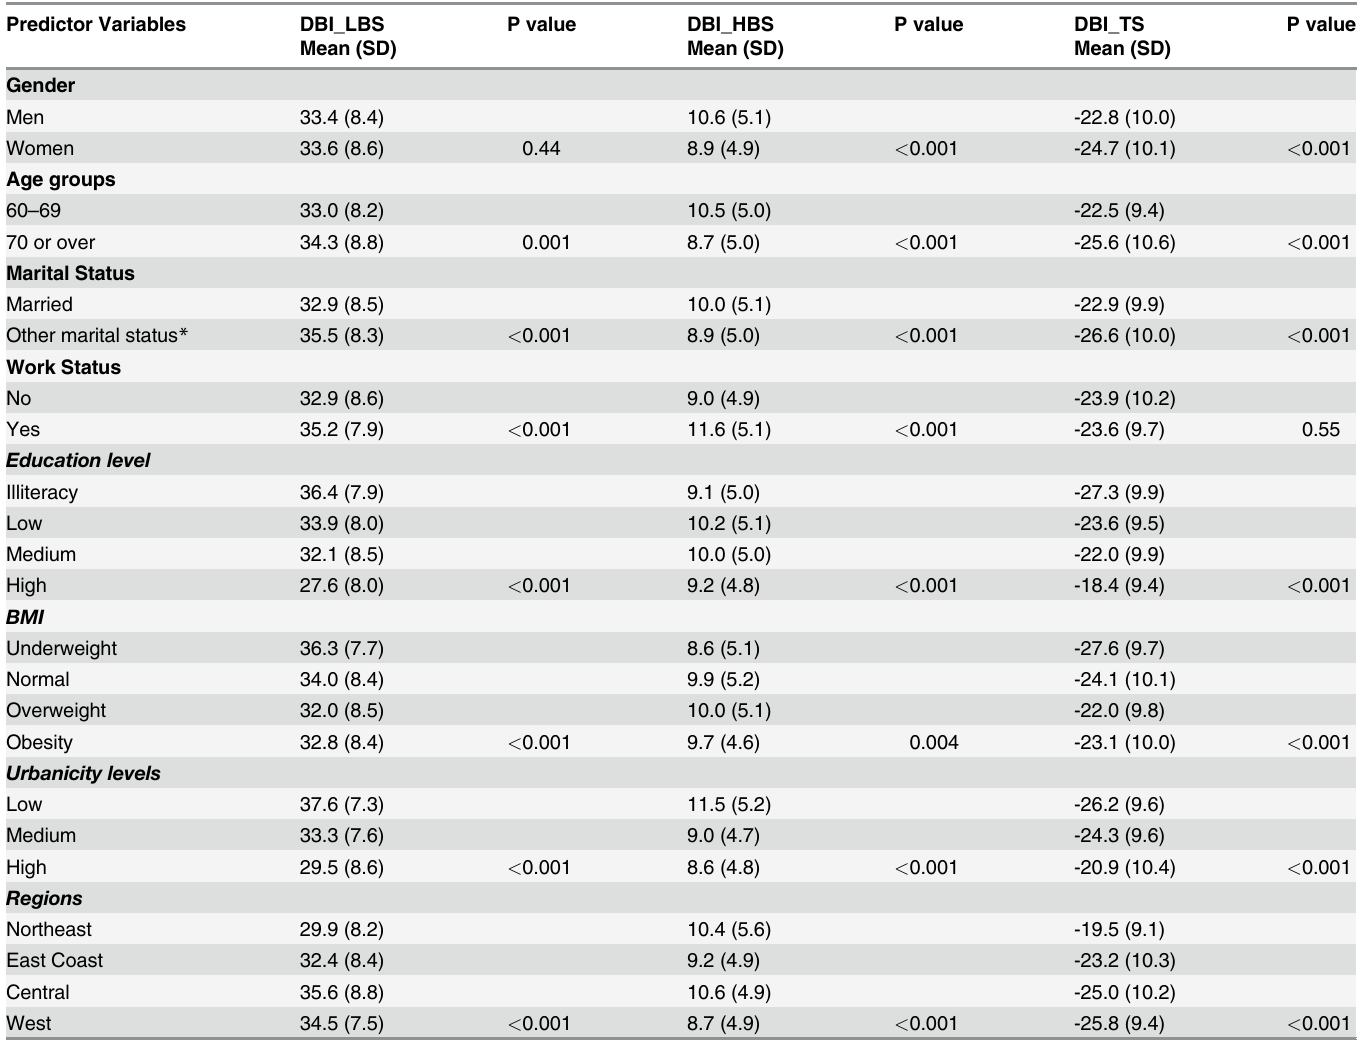
Table 4. DBI-07 score (Mean and SD) by predictor